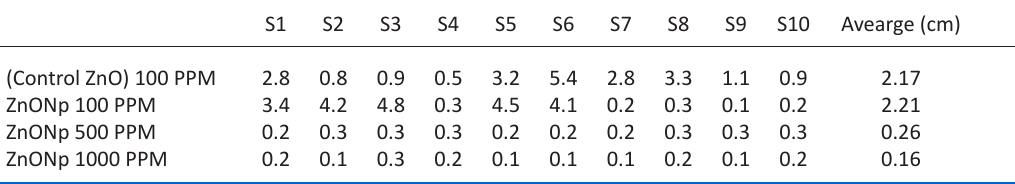
Table 4. Effect of ZnONp on root Length (cm) of Gram ( Cicer arietinum ) S1